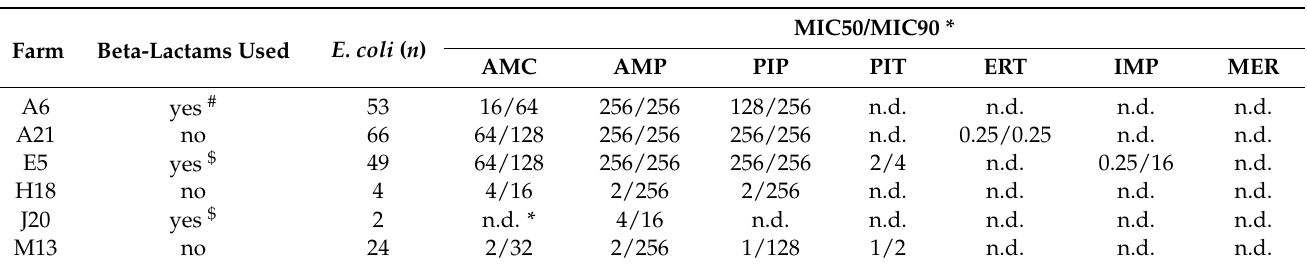
Table 10. Phenotypic susceptibility of meat-borne E. coli against beta-lactams: penicillins and car- bapenems.